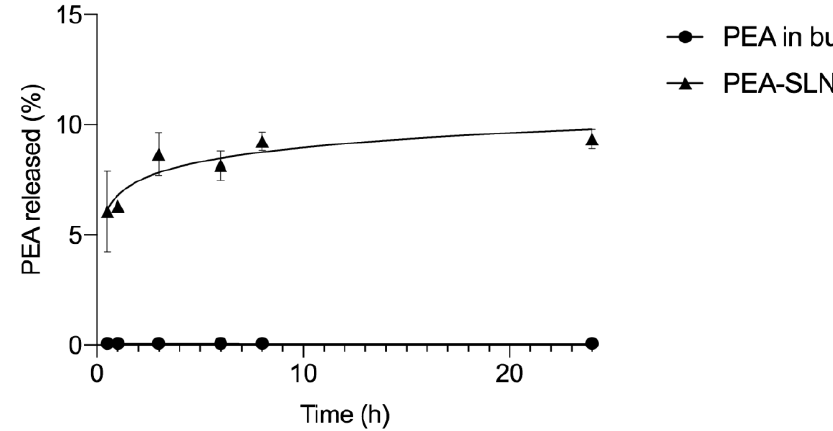
Figure 4. Release of PEA from PEA-SLNs and dissolution of PEA in bulk using PBS as medium. Results are presented as the average ± SD ( n = 3).